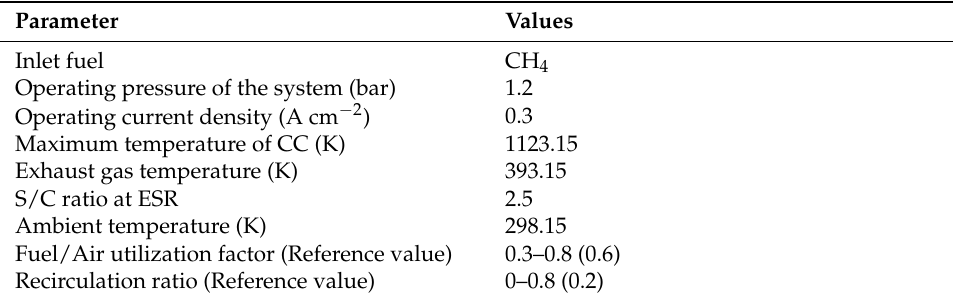
Table 9. Operating conditions for the